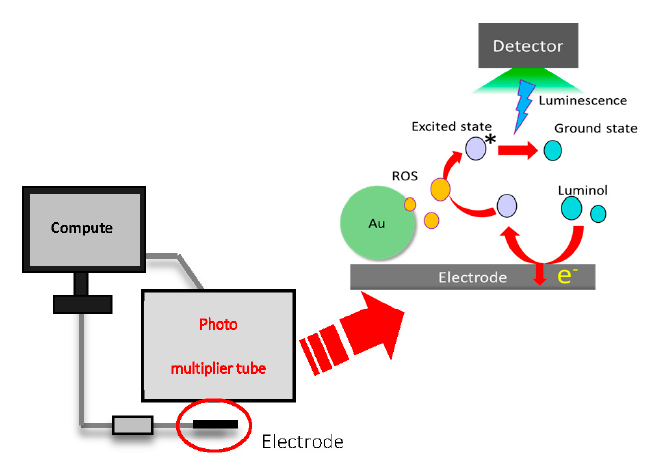
Figure 1 . Device and measurement principle of